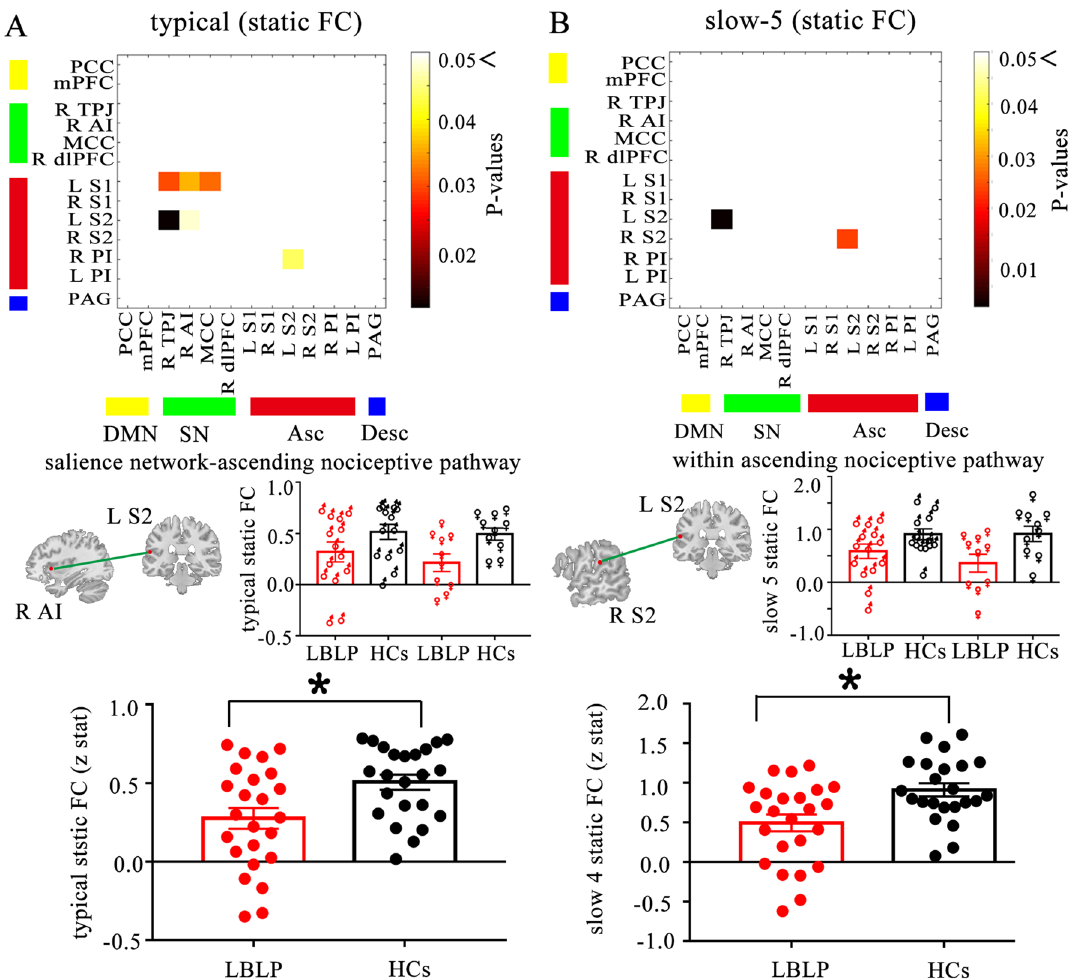
Figure 2. Static functional connectivity. Matrices indicate significant group differences in the typical ( A ) and slow-5 frequency bands ( B ). Two-sample t test, P < 0.05, FDR correction. Note: Examples of the sFC of the HCs and LBLP groups are shown below, where lines indicate the means ± standard error. HCs healthy controls, LBLP low back-related leg pain, AI anterior insula, S2 secondary somatosensory cortex.